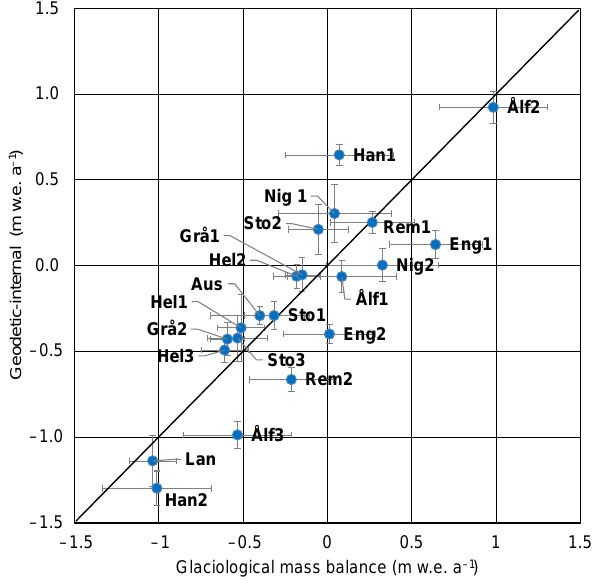
Figure 7. Glaciological vs. geodetic mass balance, subtracting the calculated internal mass balance from the geodetic balance, with error bars for glaciological and geodetic. Glacier names are shown with three characters as in Fig. 1. Numbers are added for glaciers with multiple geodetic periods; e.g. Eng1 refers to the first geodetic period and Eng2 to the second period for